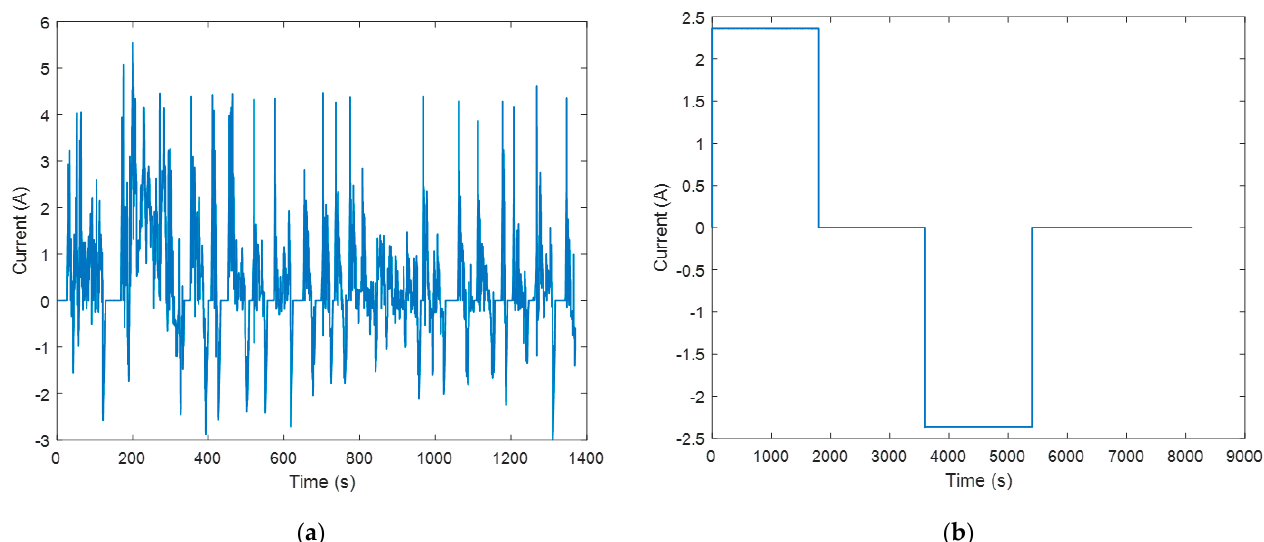
Figure 5. Validation current profiles for the four batteries, ( a ) UDDS cycle, and ( b ) ND cycle.